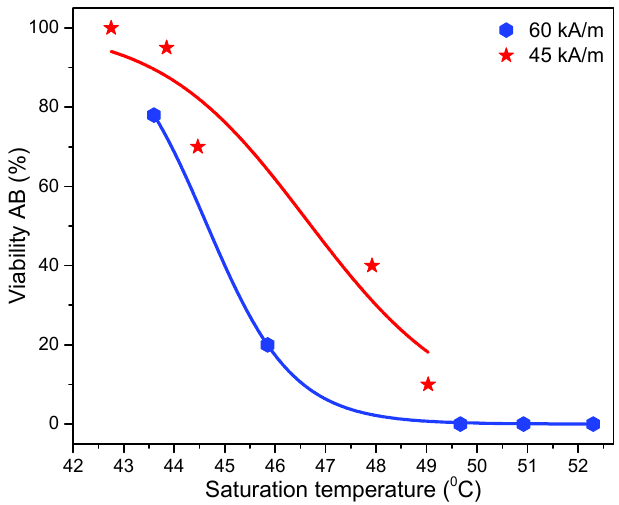
Figure 9. The viability data for A459 cells based on the AB assay as a function of saturation temperature for different amounts of internalized IOMNPs by the cells. The lines represent fittings with the Hill function.